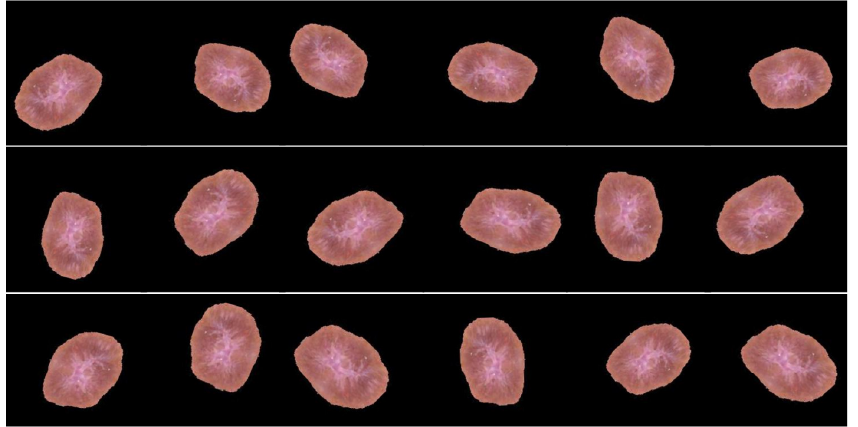
Figure 6. Samples of image augmentation for the same image.